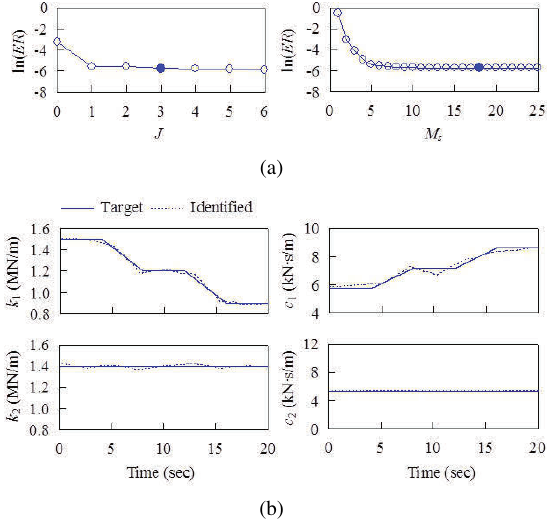
Figure 8. Identification of damaged substructure with 5% RMS noise: (a) resolution level and significant term selec- tion and (b) the identified